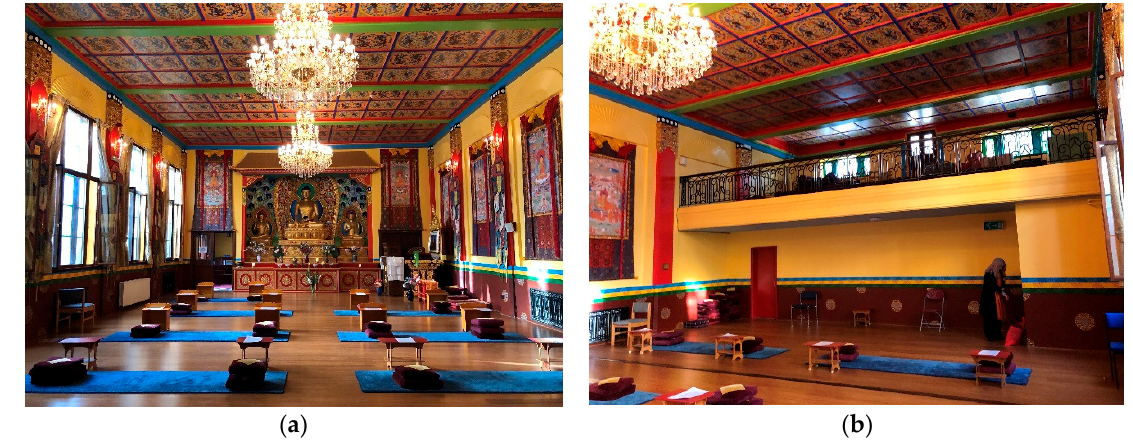
Figure 6. ( a ) Main shrine room (photo by primary author); ( b ) balcony of the main shrine room (photos by primary author).